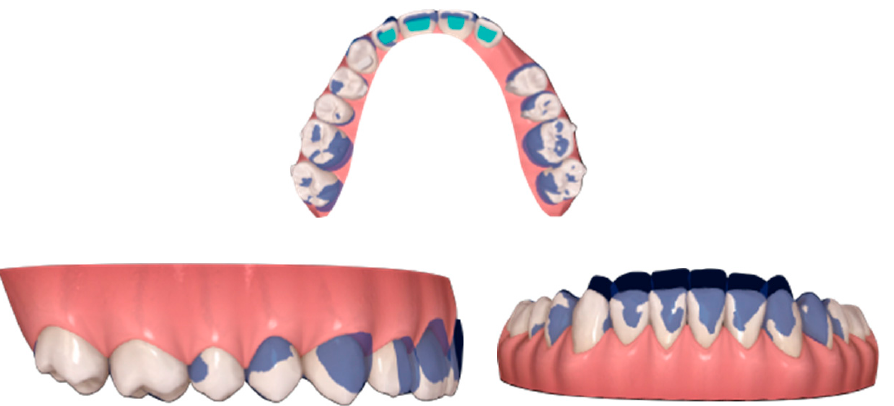
Figure 3. Digital setup planned with expansion and proclination.